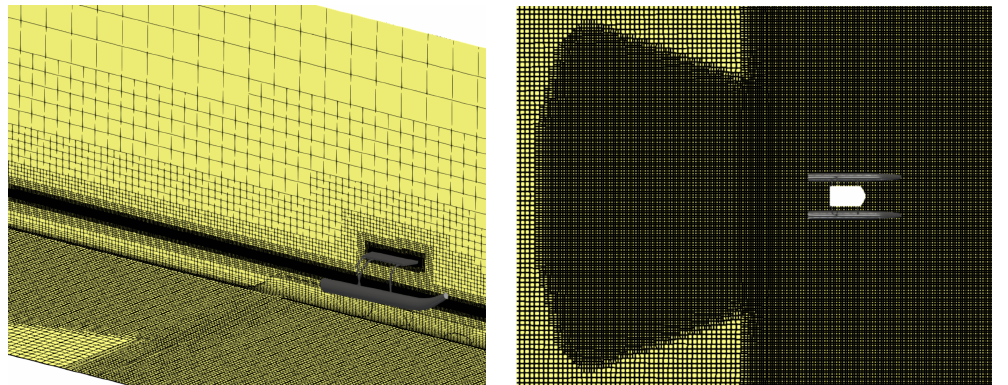
Figure 6. Mesh generation on the bottom boundary.